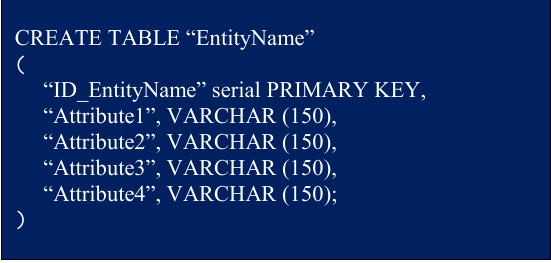
Figure 4: SQL: CREATE TABLE